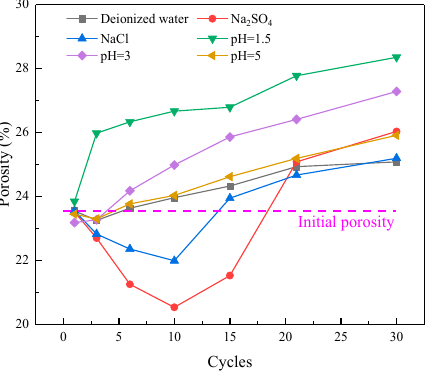
Figure 6. Variation of the porosity of hardened backfill samples with di ff erent drying-wetting cycles.